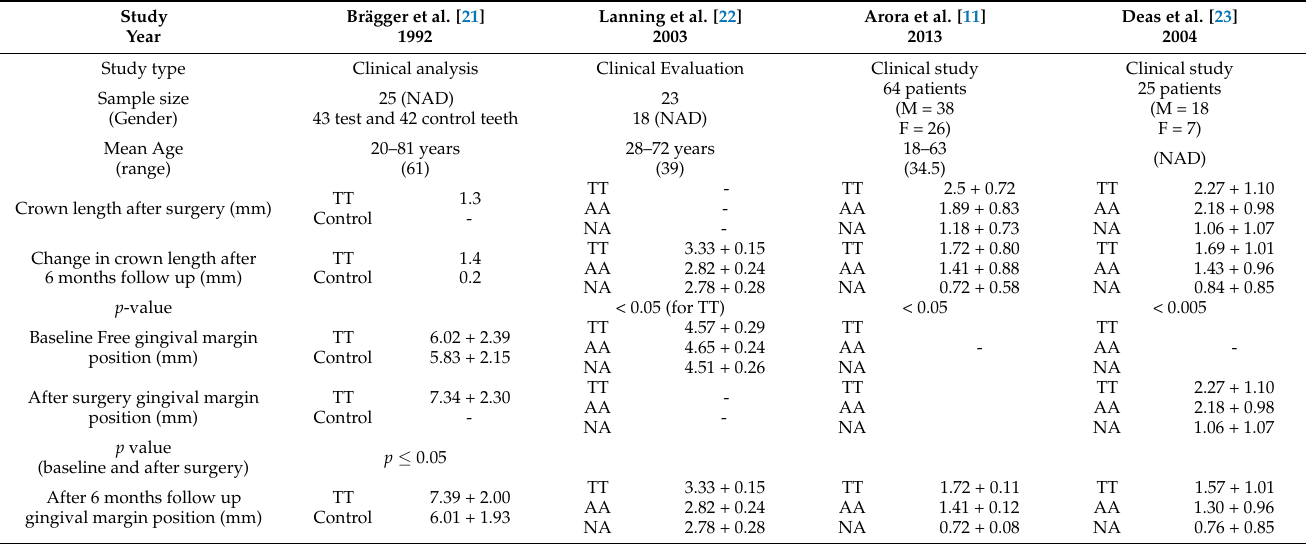
Table 1. Summary table of studies for CL